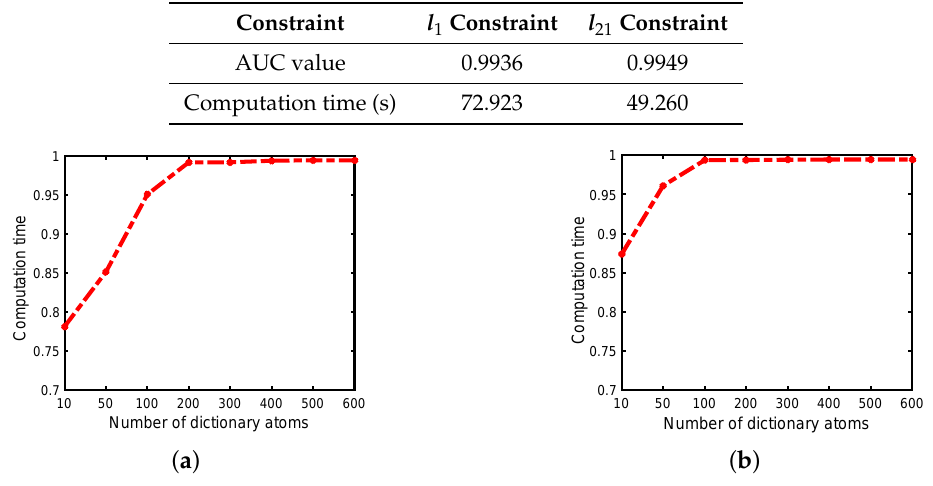
Figure 8. AUC values achieved by LRR under different numbers of dictionary atoms for the San Diego dataset. ( a ) l 1 constraint; ( b ) l 21